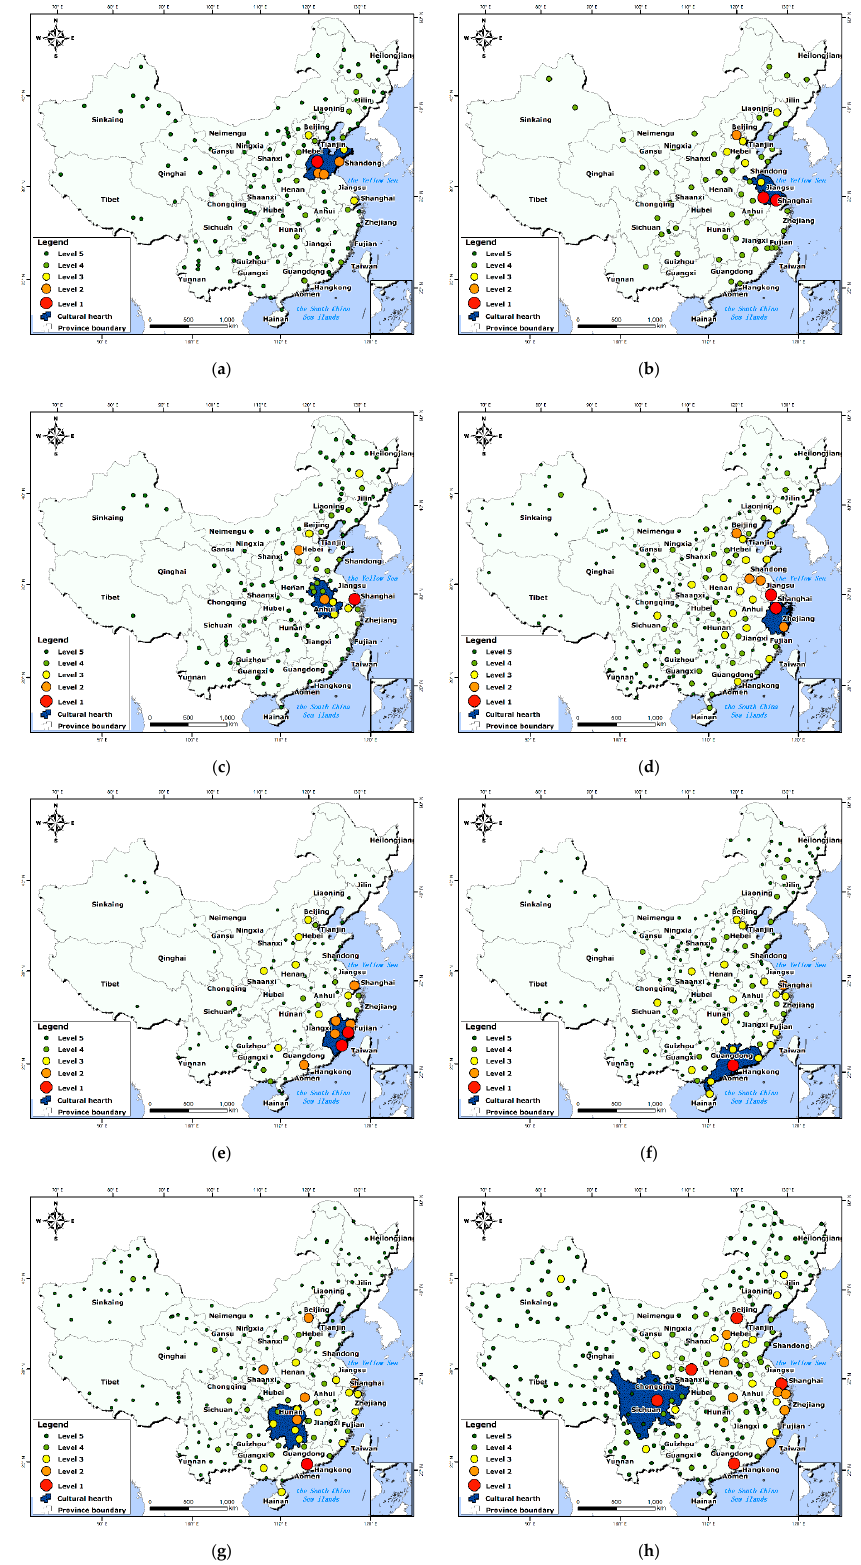
Figure 3. Results of hotspots detecting and divide rank of Eight Chinese cuisine, ( a ) Shandong cuisine, ( b ) Jiangsu cuisine, ( c ) Anhui cuisine, ( d ) Zhejiang cuisine, ( e ) Fujian cuisine, ( f ) Guangdong cuisine, ( g ) Hunan cuisine, ( h ) Sichuan cuisine respectively.